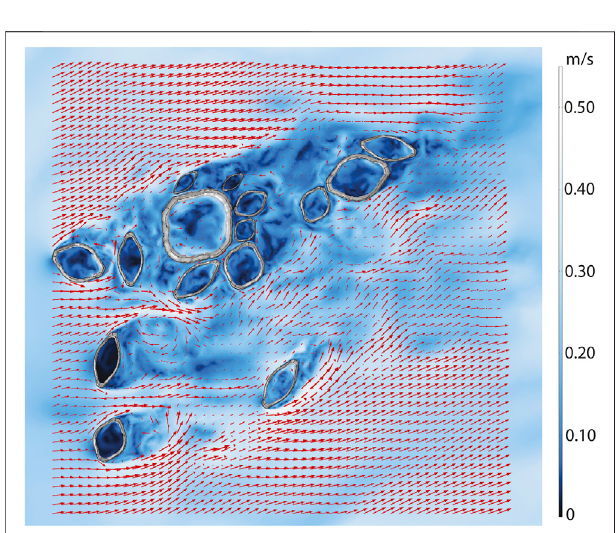
FIGURE 4 | Top view of instantaneous ( t (cid:2) 30 s) large eddy simulation computational fl uid dynamics fl ow fi eld results for Farm Hansburg Ernietta population. Arrow sizes are proportional to U